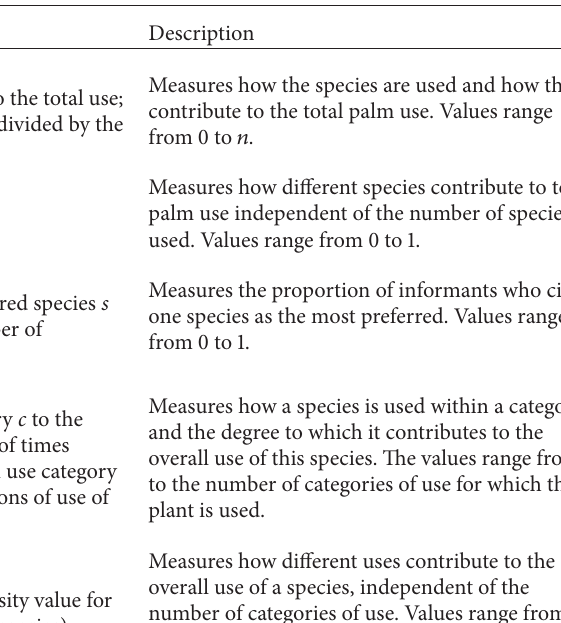
Table 1: Indexes used to analyze the knowledge and use of palms in the Kalunga Community Engenho II, Cavalcante, GO, central western Brazil [2, 42,